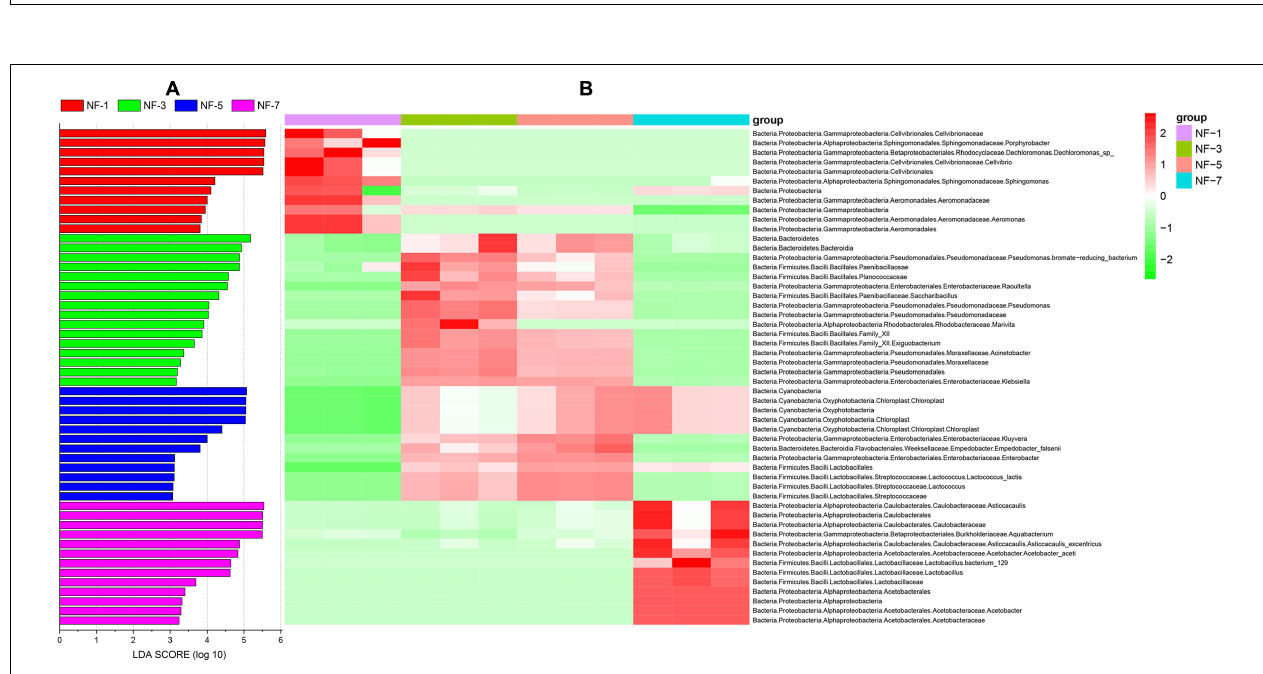
FIGURE 2 | Analysis of sour porridge biomarker by LEfSe analysis based on each taxonomy level. (A) Histogram of LDA values (log 10) higher than 3; (B) heatmap of the relative abundances of different biomarker based on LEfSe analysis and related taxonomic information at different levels.